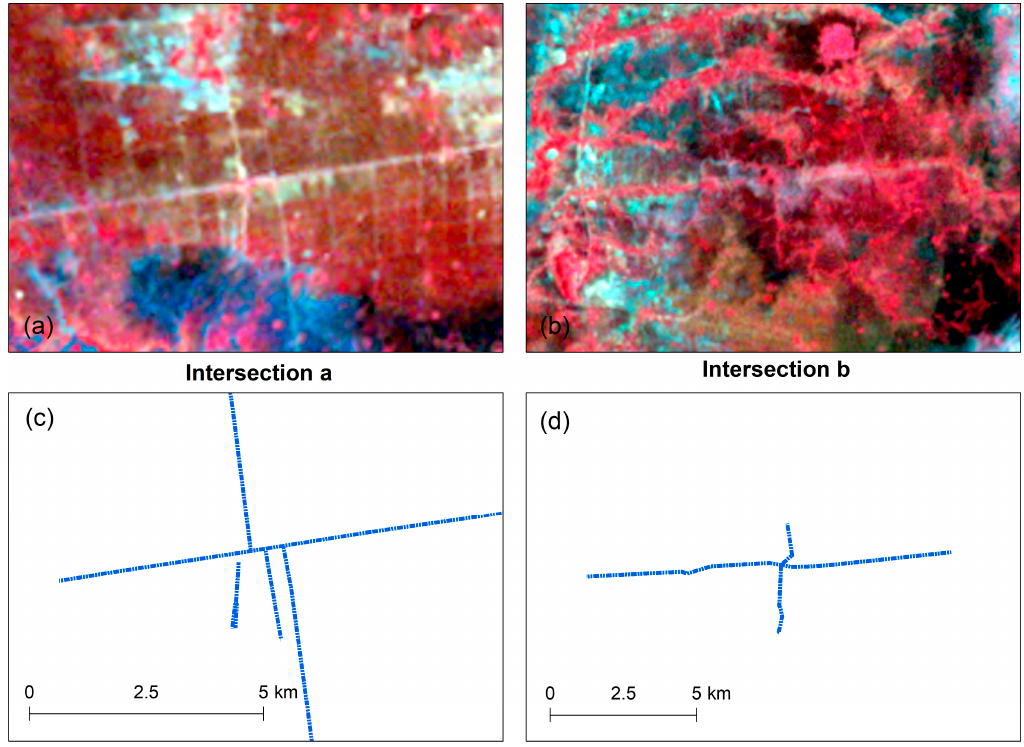
Figure 8. Detail of Landsat 3 path/row 137 051, showing two similar intersections in the 1979 false color imagery. Their paths are highlighted in blue below the Landsat image. Intersection a ( a , c ) displays canals, and intersection b ( b , d ) was revealed to be roadways.